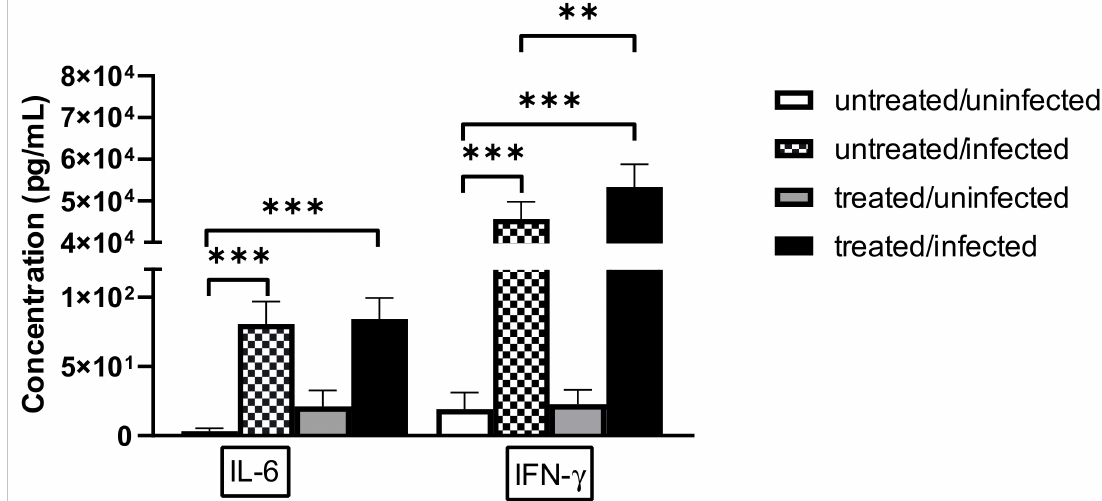
Figure 3. Concentrations of IL-6 and IFN- γ in lung supernatants. Mice were infected intranasally with C. pneumoniae and treated with 5-mg/kg Ax for 6 days or left untreated and uninfected. On the seventh day post-infection, the mice were euthanized and the concentrations of IL-6 and IFN- γ in the supernatants of the lungs were measured via ELISA. Each bar denotes the mean ± standard deviation for 10 mice (** p < 0.01, and *** p <